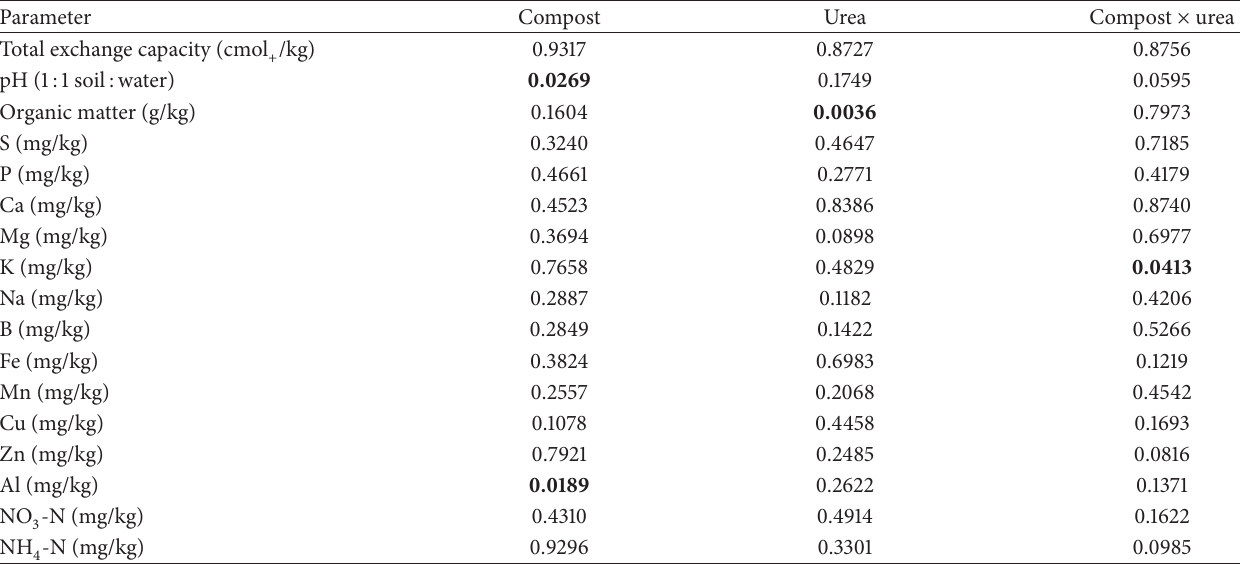
Table 9: Treatment P values for the difference between postexperiment soil fertility parameters and preexperiment parameters in the 15 to 25 cm stratum. Each row represents a single model. Models include block as a random effect. Elemental analyses are for Mehlich-3 extractable elements. Significant effects ( P ≤ 0.05) are in bold.